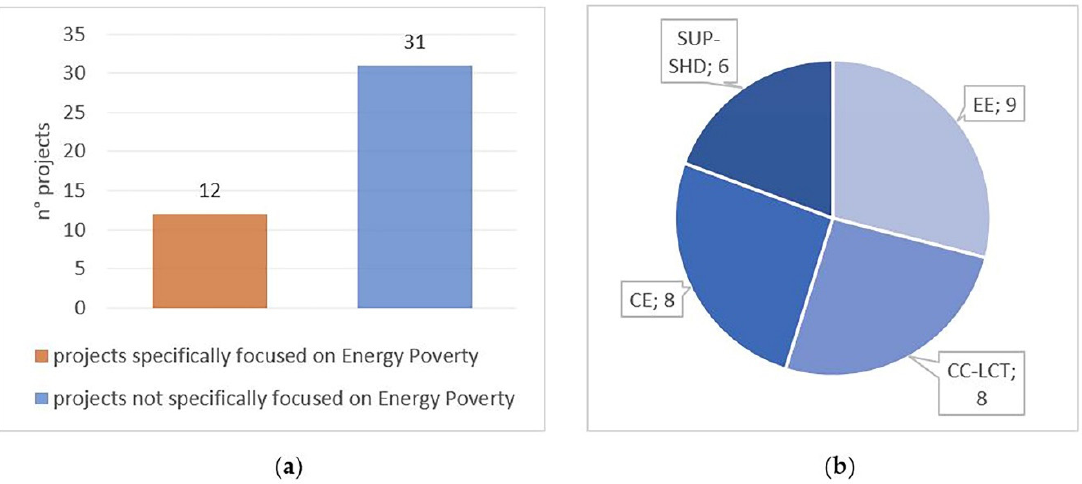
Figure 7. ( a ) Number of projects specifically focused on energy poverty and projects not specifically focused on it; ( b ) main issues addressed by projects not specifically focused on energy poverty (CC- CET — climate change and low carbon transition; EE — energy efficiency; CE — citizens engagement; (CC-CET—climate change and low carbon transition; EE—energy e ffi ciency; CE—citizens SUP-SHD — sustainable urban planning and social housing districts). Image elaborated by the authors.